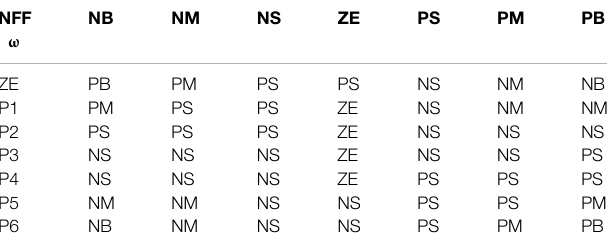
TABLE 2 | Fuzzy rules for given member functions.